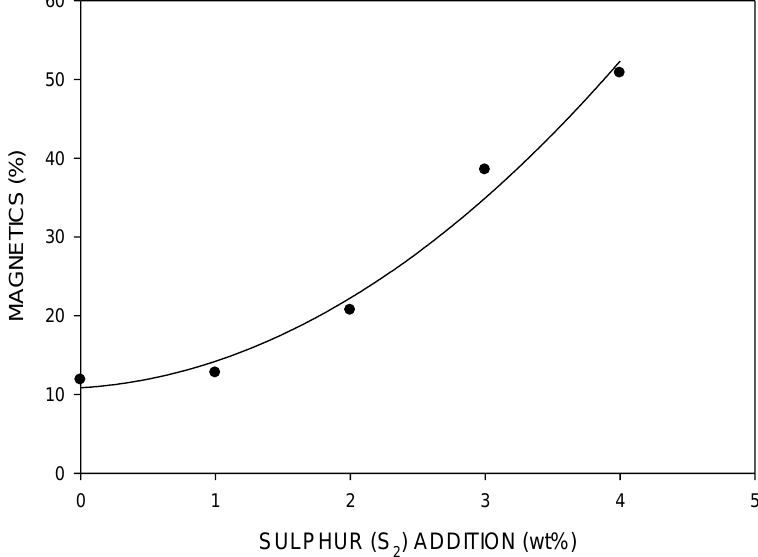
Figure 12: Effect of sulphur additions on the percent magnetic material. Figure 12. Effect of sulphur additions on the percent magnetic material. Figure 12. Effect of sulphur additions on the percent magnetic material.